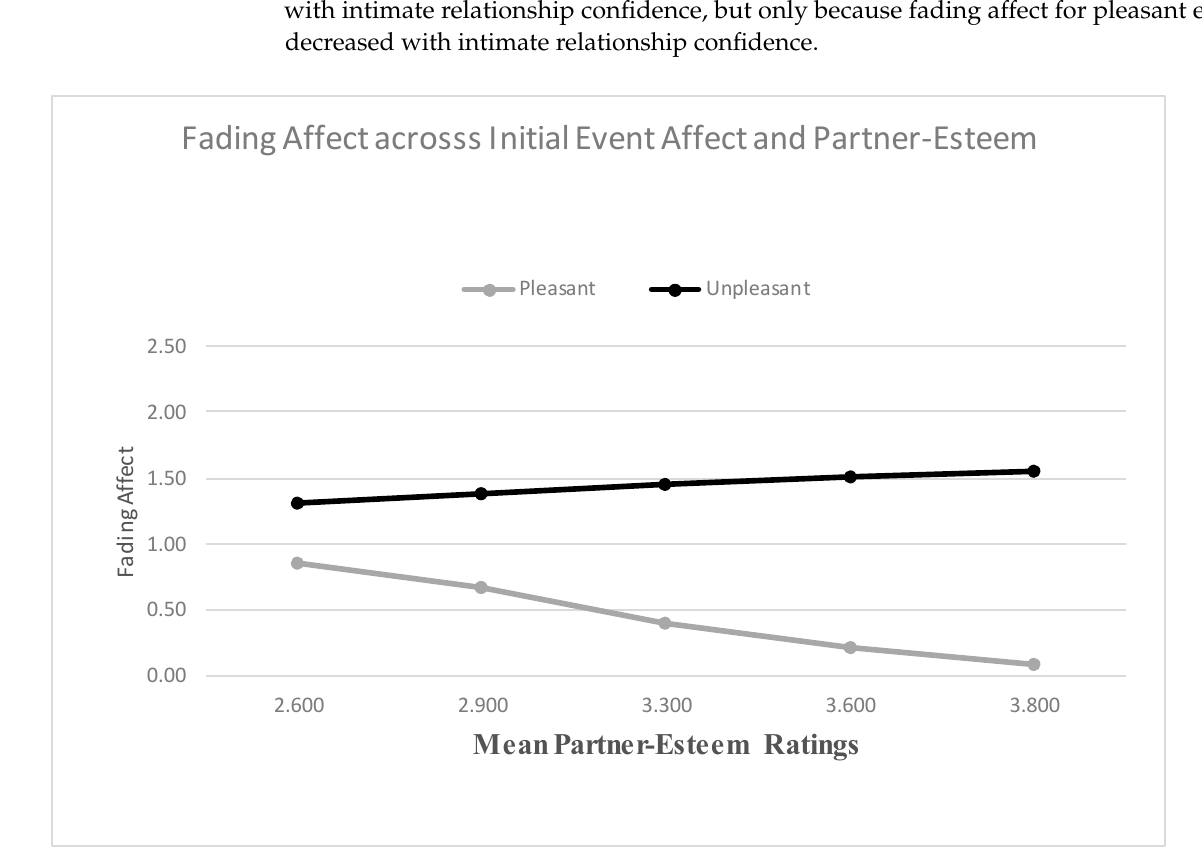
Figure 4. Fading affect for pleasant and unpleasant events across quintile levels (10th through 90th) of partner ‐ esteem.